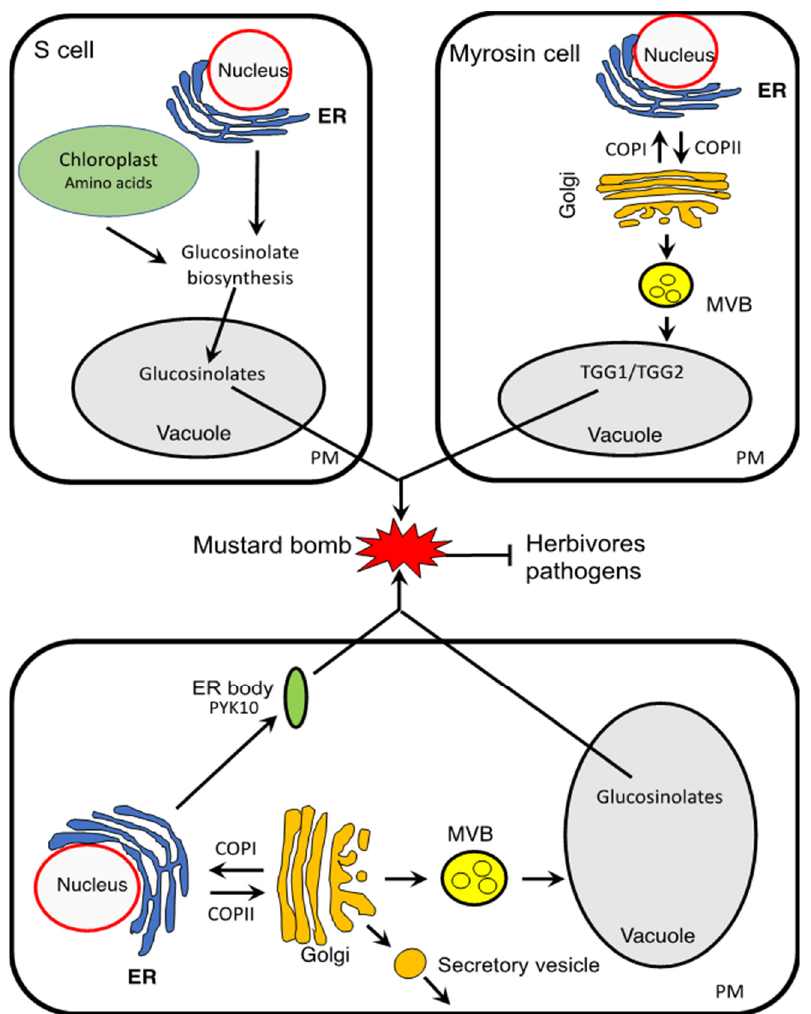
Figure 2. Two types of the mustard oil bomb. In the dual-cell type of the mustard bomb, glucosinolates are stored in the S cells, whereas classical myrosinases such as TGG1 and TGG2 from Arabidopsis accumulate in the vacuole of myrosin cells. In the single-cell type mustard oil bomb, atypical myrosinases such as PYK10 and glucosinolates accumulate in the ER bodies and vacuole of the same cell. Upon tissue damage, myrosinases obtain access to glucosinolates to detonate the mustard oil bomb by generating chemically active compounds toxic to herbivores and pathogens. ER, endoplasmic reticulum; PM plasma membrane; MVB, multivesicular body.